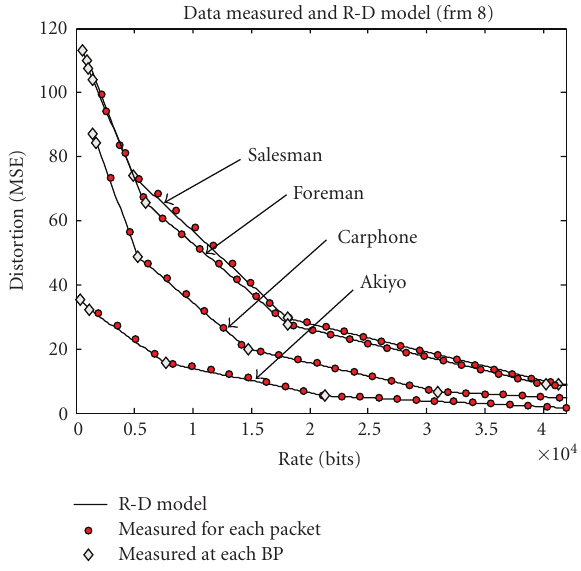
Figure 5: Comparison between the measured data and the R-D curve calculated from the BP data.